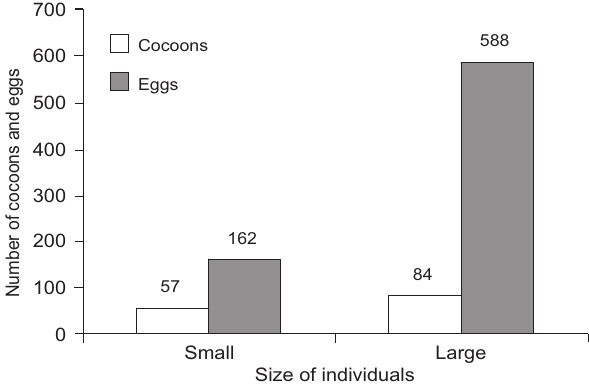
Figure 1. Number of cocoons and number of eggs laid by Limnodriulus hoffmeisteri by small (initial average weight 6.63 ± 1.28 mg) and large individuals (initial average weight 12.44 ± 3.99 mg), at 15 ±